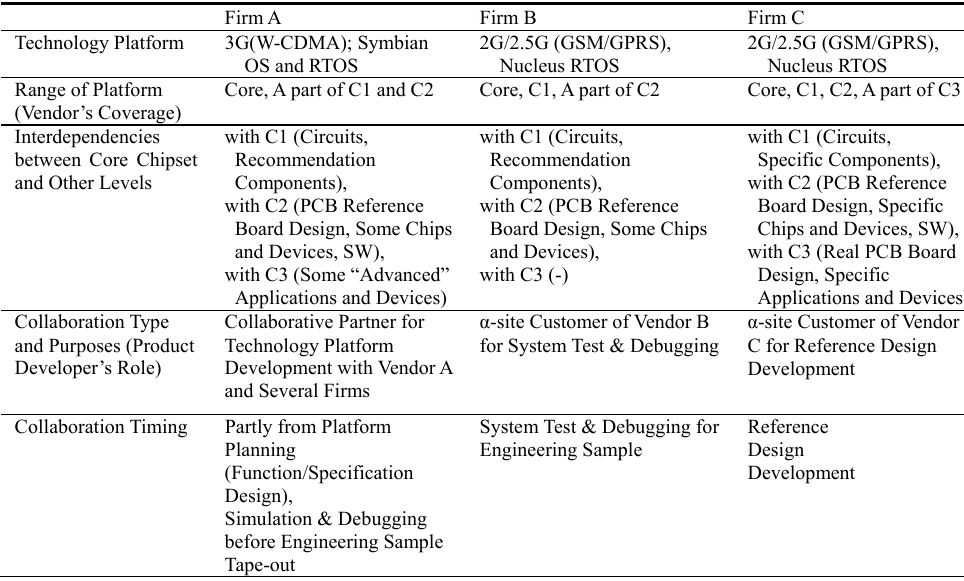
Table 2. Brief description of differences in